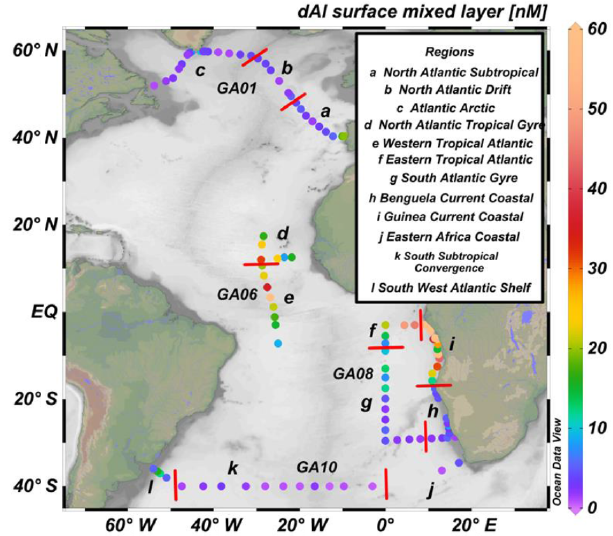
Figure 3. Surface mixed-layer dAl concentrations (nM) for the cruises used in this study (GA01, GA06, GA08, and GA10). Red lines divide the different biogeochemical provinces used in this